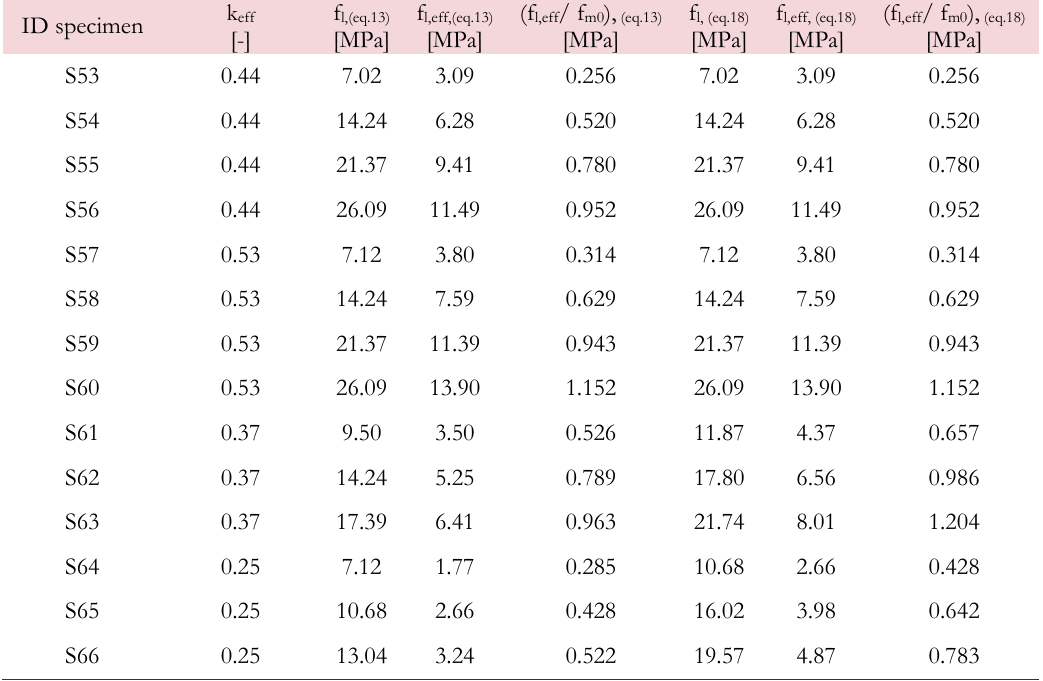
Table 14.B: Effective confining stress calculated according to Eqn. (13) and (18) for the experimental program,